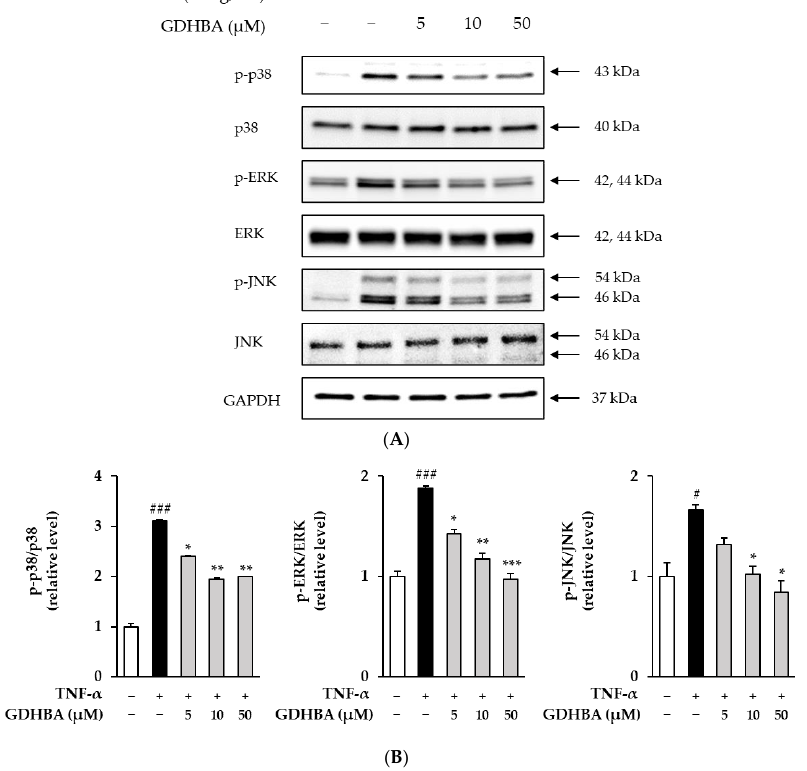
Figure 4. Effect of GDHBA on phosphorylation of MAPKs in TNF- α stimulated HDFs. HDFs were pretreated with 5, 10, and 50 μM of GDHBA for 1 h and then incubated with TNF- α (20 ng/mL) for 15 min. Expression of p-p38, p38, p-ERK, ERK, p-JNK, JNK, and GAPDH was determined using Western blotting. Each bar represents mean ± SEM. # p < 0.05 and ### p < 0.001 versus normal control. * p < 0.05, ** p < 0.01, and *** p < 0.001 versus stimulus alone.